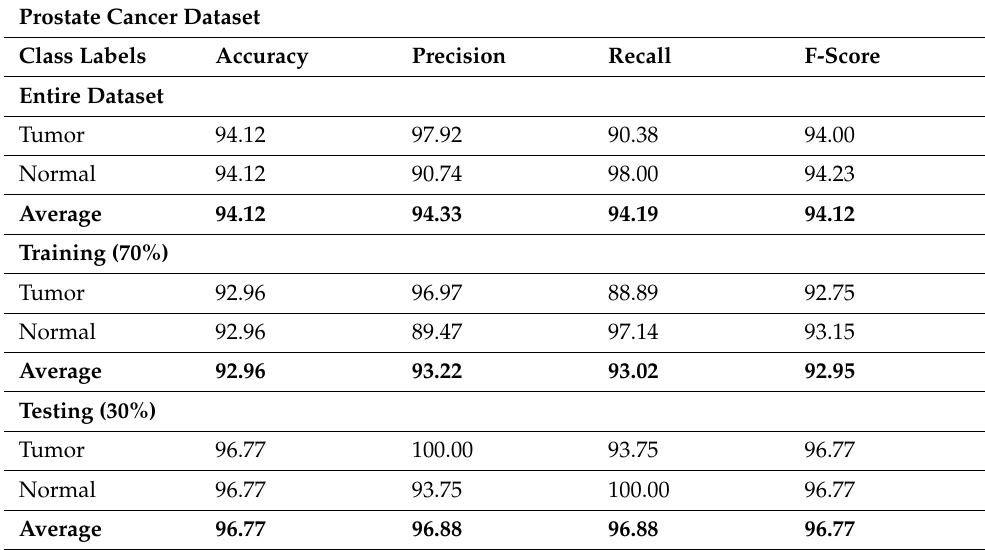
Table 2. Resulting analysis of RFODL-MGEC technique with various measures on prostate cancer dataset.